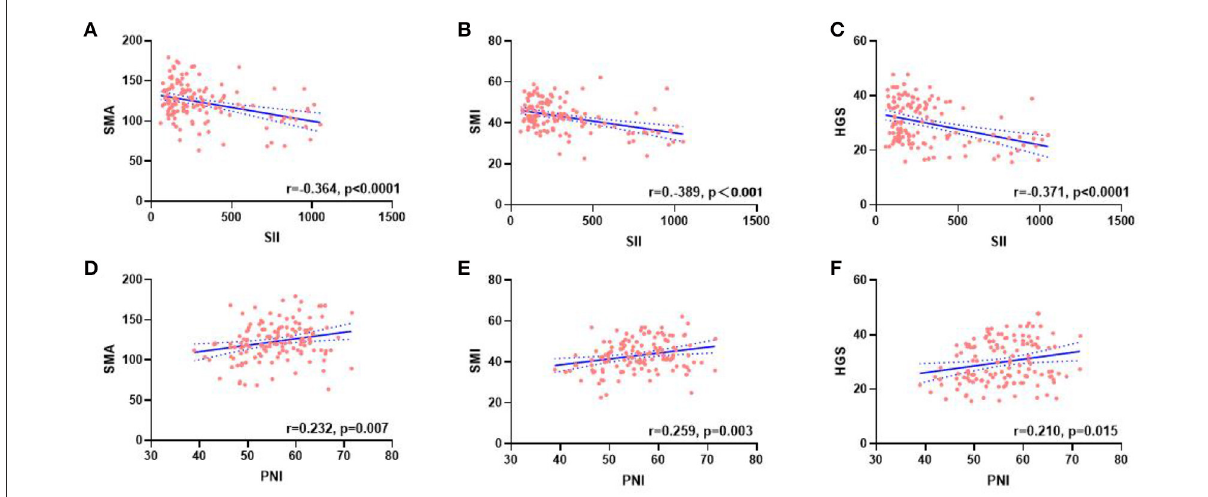
FIGURE3 Correlation between the SII (A–C) , PNI (D–F) , and SMA, SMI, and HGS. SII, systemic inflammatory immunity index; PNI, prognostic nutritional index; SMA, skeletal muscle area; SMI, skeletal muscle mass index; HGS, handgrip strength.